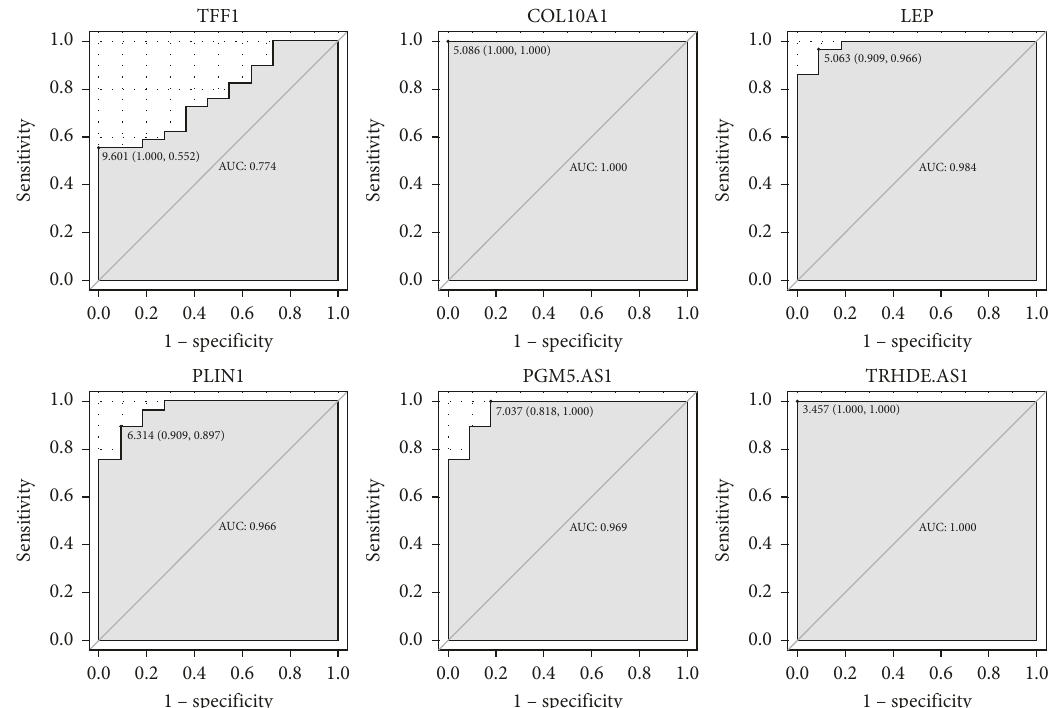
Figure 10: ROC curve. The x -axis indicated 1